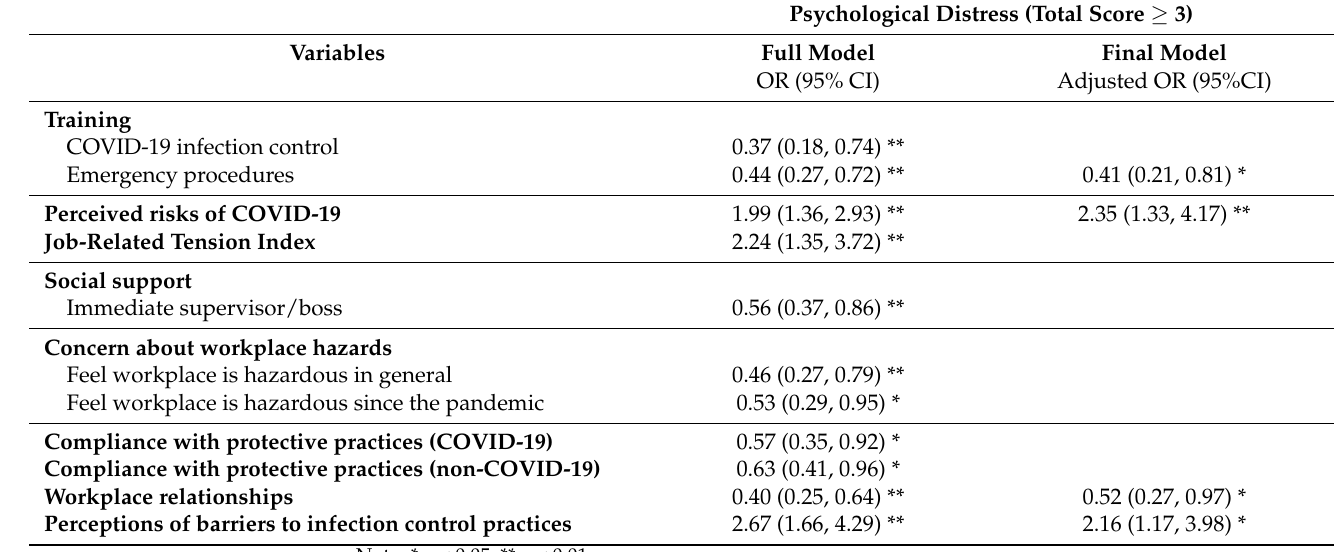
Table 6. Multiple logistic regression models on psychological distress by major